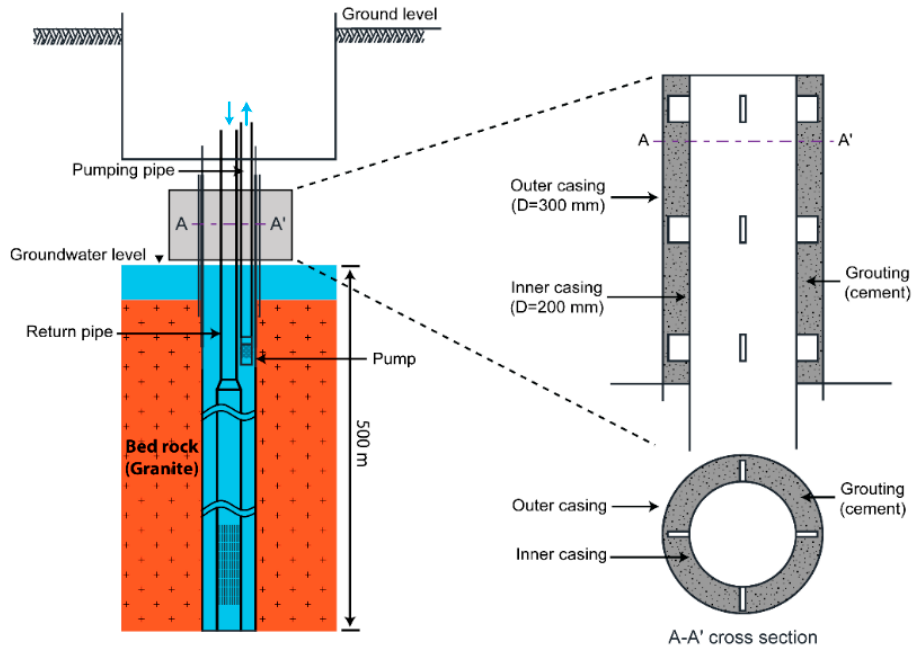
Figure 2. The schematic diagram of the GWHPs well.